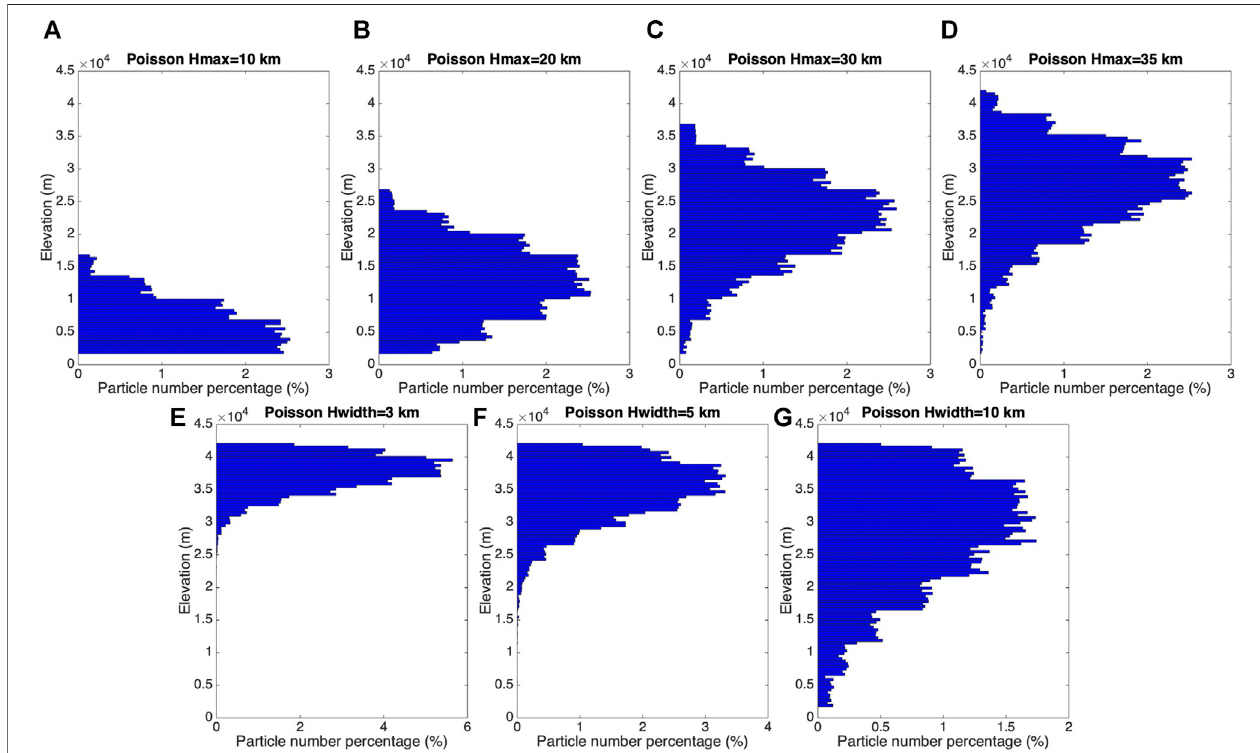
FIGURE8| InitialparticledistributioninverticaldirectionbasedonPoissonplumeshape( Eq.13 ).The fi rstrowvariesplumeheights. (A) to (D) arecorrespondingto plumeheight of 10 km, 20 km, 30 km, 35 km. Another parameter, H width is 6662 m for all four fi gures inthe fi rst row. The second row varies “ vertical spread ” , H width . (E) to (G) are corresponding tovertical spread of3 km, 5 km,and 10 km.Theplumeheight, H max , isset to40 kmforall three fi gures. The x axisisthepercentageofparticle numbers. See Figure 7 for vertical ash distribution of Plume-SPH output.